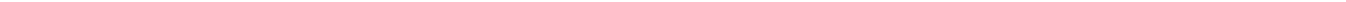
Fig. 6 OTUD1 cleaves K33-poly-ubiquitin chain on SMAD7 Lysine 220. a K220 ubiquitination of SMAD7 identi fi ed by mass spectrometry. Right: Comassie staining of Flag-SMAD7 precipitations. b Sequence alignment of the PY motif and identi fi ed K220 ubiquitination site in SMAD7 orthologs of different species. c Immunoblot (IB) of total cell lysate (TCL) and immunoprecipitates derived from Flag-SMAD7 overexpressing HEK293T cells transfected with K6-, K11-, K27-, K29-, K33-, K48-, and K63-linked HA-Ub constructs and Myc-OTUD1 as indicated. d IB of TCL and immunoprecipitation derived from HEK293T cells transfected with wt, K27-, K33-, K48-linked HA-Ub, together with Flag-SMAD7-wt or K220R mutant as indicated. e Upper panel: the model of WW domain of E3-ubiquitin ligase Smurf2 binding to PY loop (residue 203-220) of SMAD7. Middle and lower panels: the model of mono-ubiquitin (PDB ID: 2XK5) conjugation to PY loop (residue 203-220) at residue Lys220. Both WW domain (green) and PY loop (red) were shown in ribbon, ubiquitin was shown in gray surface, and the key residues involved in domain interaction are drawn in stick representations. f IB of TCL and anti-SMAD7 immunoprecipitants derived from K33-linked HA-Ub expressing HEK293T cells depleted of OTUD1. g IB of TCL and Nickle-pull down precipitants derived from K33-linked His-Ub expressing HEK293T cells transfected with Flag-SMAD7-wt/ K220R and depleted of OTUD1 as indicated. h IB of input and anti- Flag immunoprecipitates derived from HEK293T cells transfected with Flag-SMAD7-wt or K220R mutant as indicated. i IB of input and anti-Flag immunoprecipitates derived from HEK293T cells transfected with Flag-SMAD7 and depleted of OTUD1 as indicated. j CAGA 12 -Luc transcriptional response of HEK293T cells transfected with empty vector (Co.vec), SMAD7-wt or K220R at different doses as indicated and treated with TGF- β (0.5 ng/ ml) overnight. k IB of biotinylated cell surface T β RI in HeLa cells stably transfected with empty vector (Co. vec), SMAD7-wt or K220R mutant expression plasmids and treated with TGF- β (5 ng/ml) for indicated time points. Quanti fi cation of the band intensities is shown in the lower panel. Band intensity was normalized to the t = 0 controls. Results are shown as means ± SD of three independent sets of experiments. l Working model of